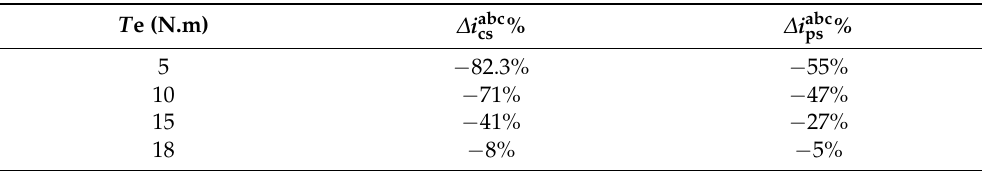
Figure 14. The comparison data of the simulation experiment of the MTPA-(SFV-FLC) control algorithm with and without parameter deviation at different torques. Table 5. When there is a deviation in the parameters, the current comparison of the two control methods of MTPA-(SFV-FLC) and (SFV-FLC) at different torques. T e % i T e (N.m) a b c c s